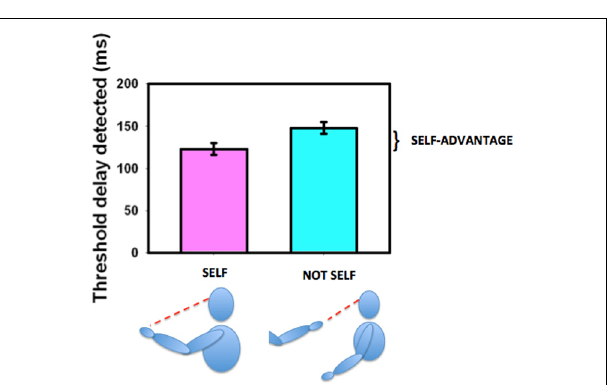
FIGURE 7 | The self-advantage for detecting a delay between moving one’s own hand and seeing the movement. When the hand is seen in the natural perspective (“self,” purple bar) the threshold for detecting delay is shorter than when the hand is viewed from the “not self” perspective (cyan bar). The improvement is known as the “self-advantage.” Data redrawn from Hoover and Harris